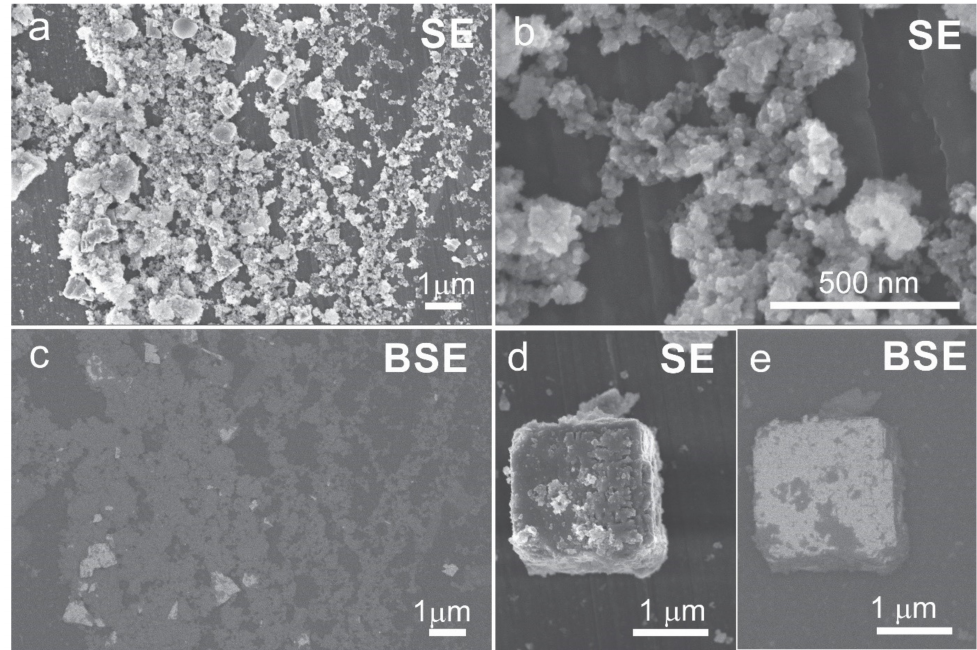
Figure 1. SEM micrographs of the PZT reaction product obtained through the one-step pre- cipitation process and hydrothermal reaction at 235 ◦ C (12 h) from the Zr- and Ti-precursors with initial Zr/Ti = 60/40 (PZT06) and at KOH:Pb = 30:1: ( a , b , d ) secondary electron (SE) images; ( c , e ) backscattered electron images (BSE) of the sample shown in SE images in ( a ) and ( d ),